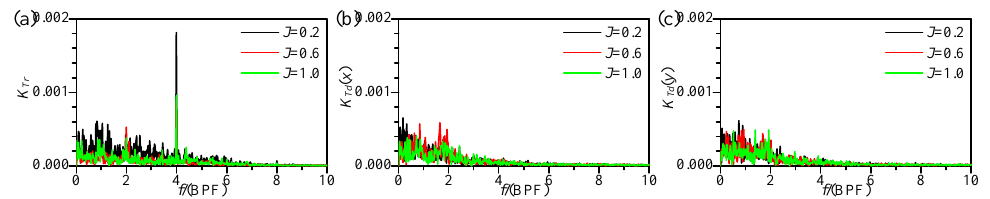
Figure 14. Frequency domain curves of K Tr , K Td ( x ) and K Td ( y ) of the PJP model S8R6: ( a ) K Tr , ( b ) K Td ( x ) , ( c ) K Td ( y )